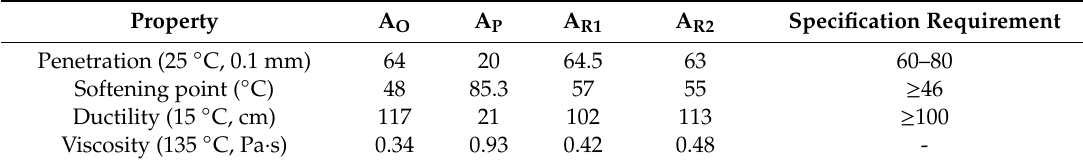
Table 6. Physical performance test results of each